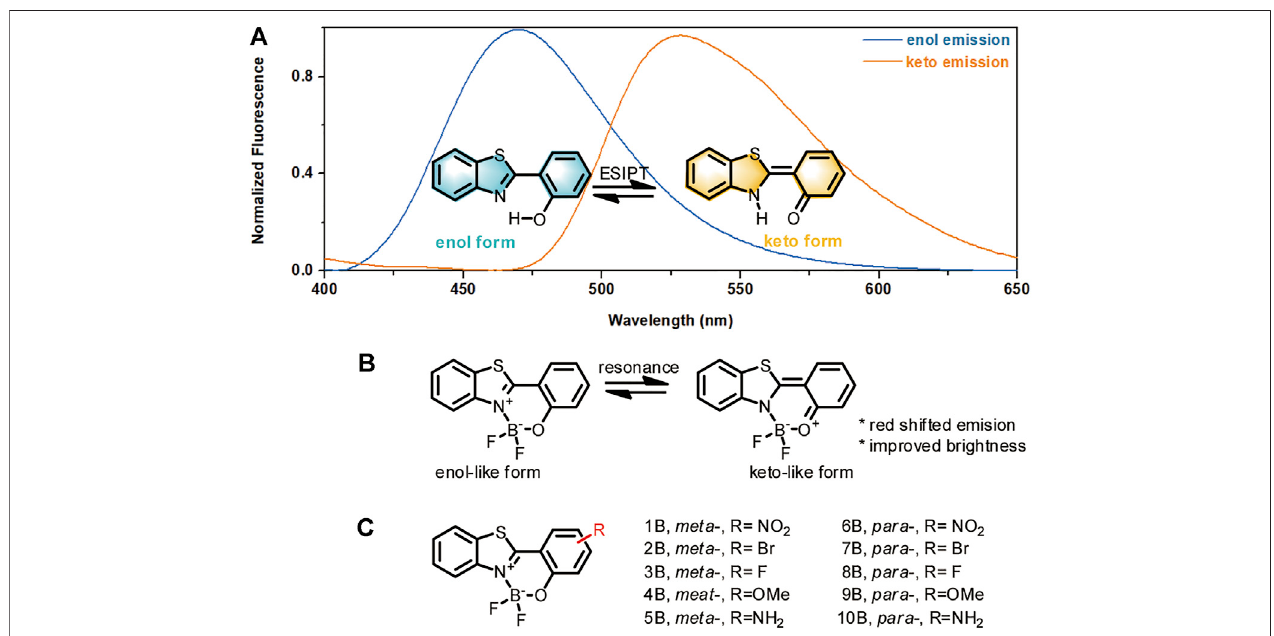
FIGURE 1 | Design rationale for HBT-BF 2 fl uorophores. (A) Enol and keto forms of HBT structures and their emissions. (B) The HBT-BF 2 structure and its resonance to a keto-like structure. (C) Structures of HBT-BF 2 series of fl uorophores with various substituents.